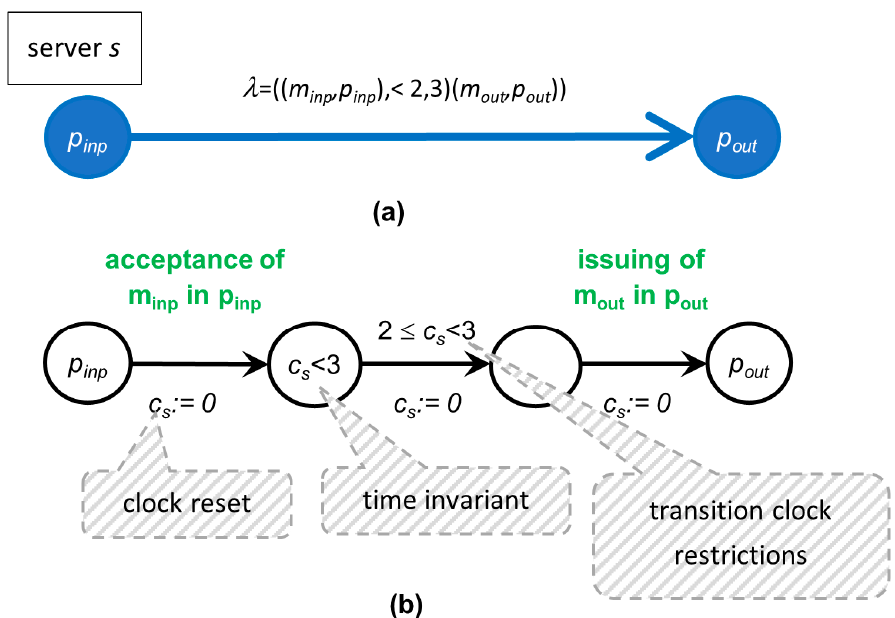
Figure 5. Rule of translation of IMDS-timed action to a sequence of transitions in a timed automaton: ( a ) IMDS timed action with duration <2,3); ( b ) timed automaton s transitions, implementing action duration.